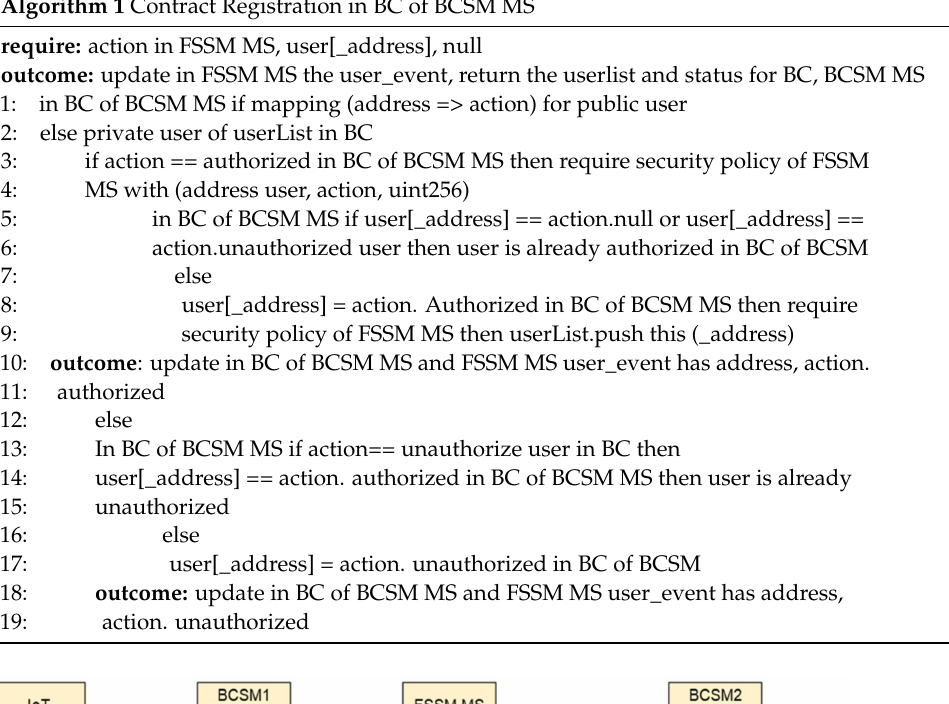
Algorithm 1 Contract Registration in BC of BCSM MS